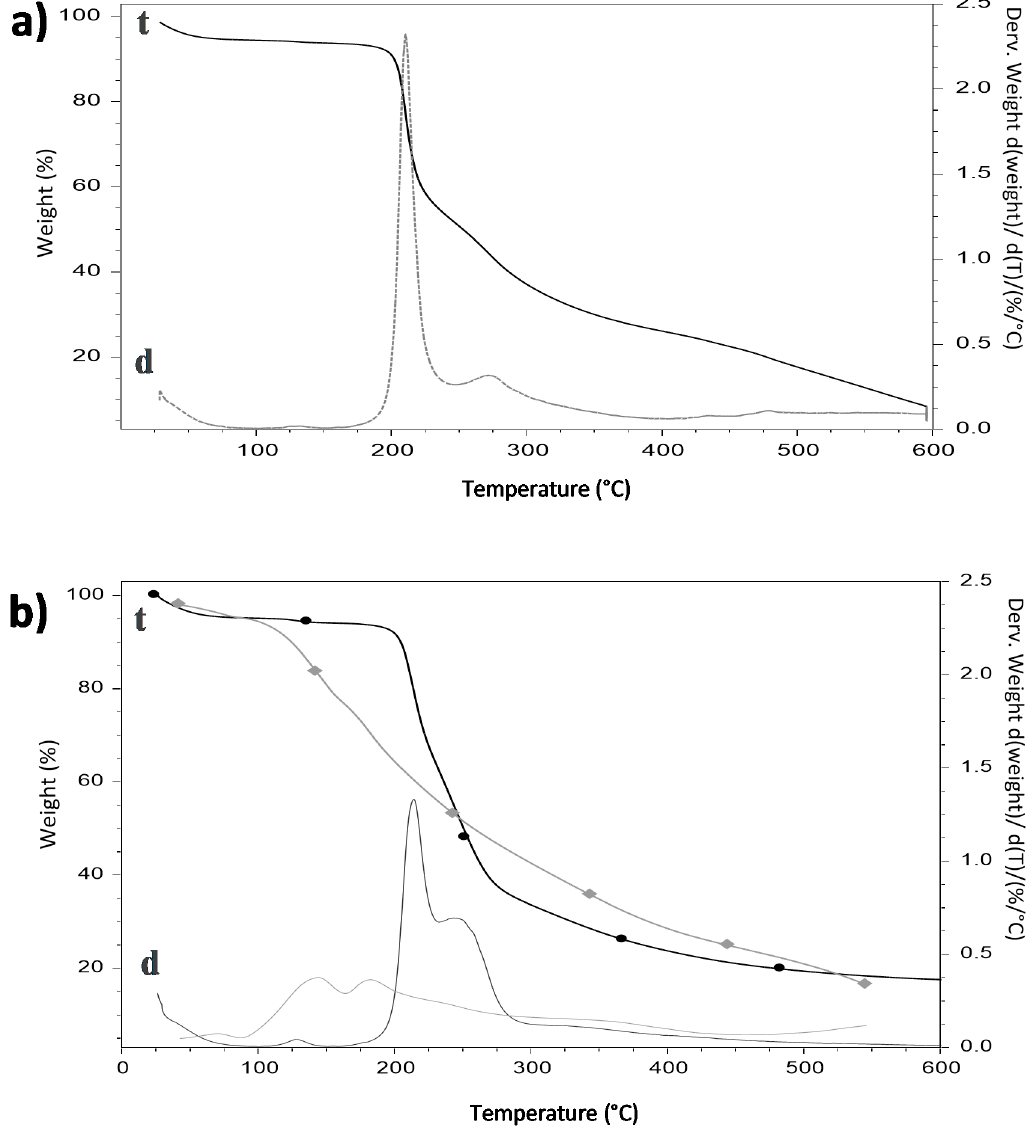
Figure 2. Thermograms of ( a ) HDPAF and ( b ) comparative ( ♦ ) β -carotene ( ● ) fi bers with β -carotene. (t, indicates thermograms and d, the derivatives of the thermograms).